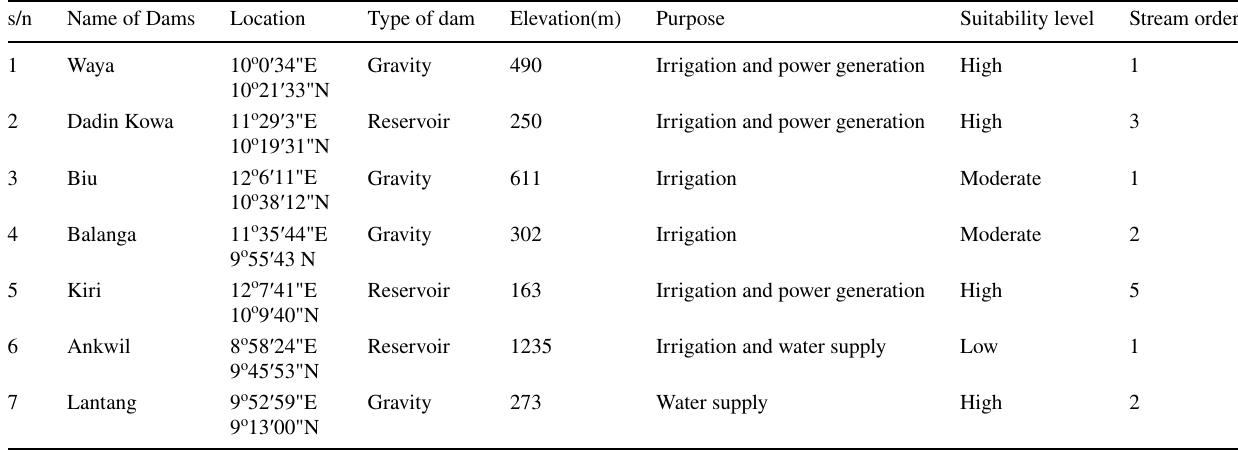
Table 5 Characteristics of the existing